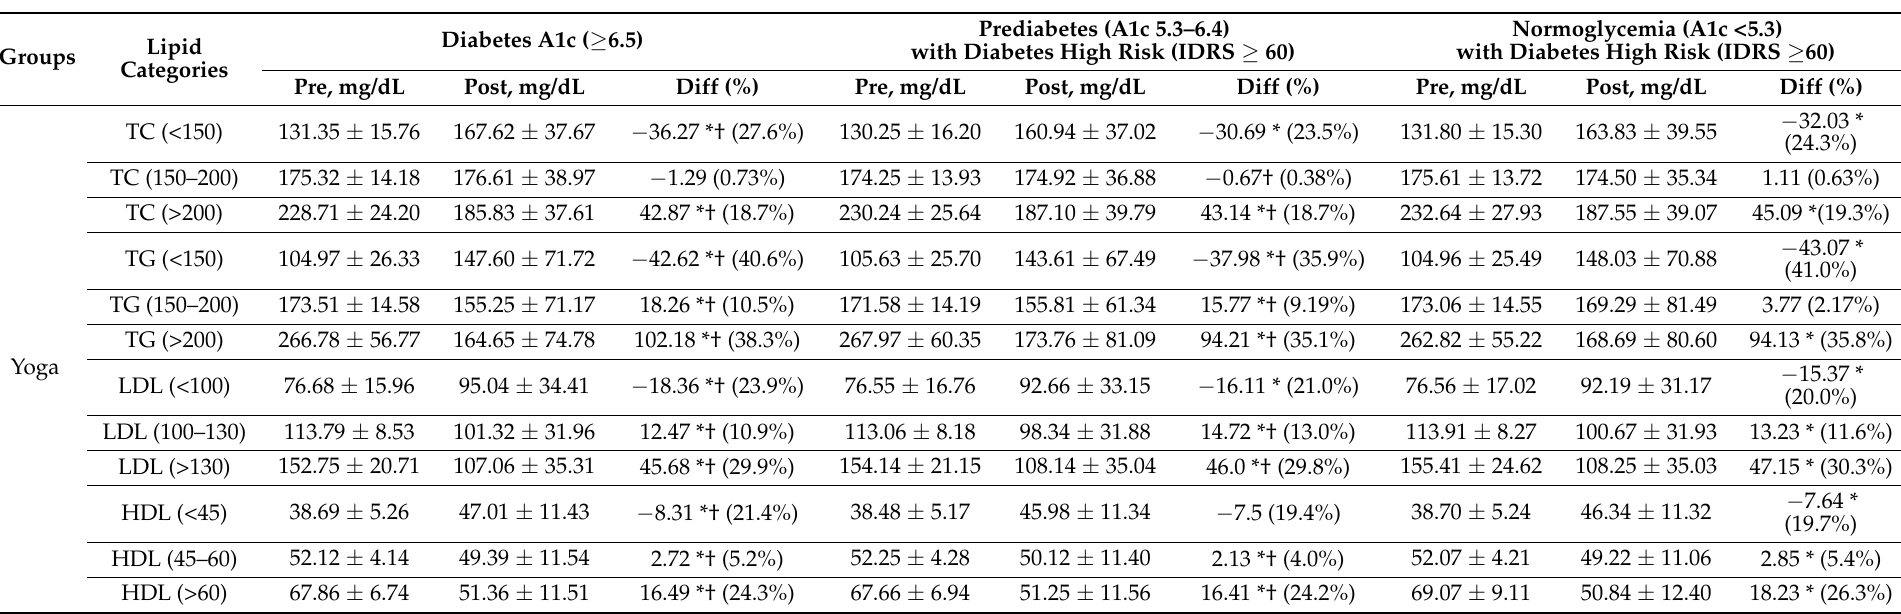
Table 3. Comparison of three subgroups (lesser than, within, and above normal range) of baseline lipid values in control and yoga groups of individuals with high risk for diabetes after three months of intervention. TC: Total Cholesterol; TG: Triglyceride; LDL: low-density lipoprotein; HDL: high-density